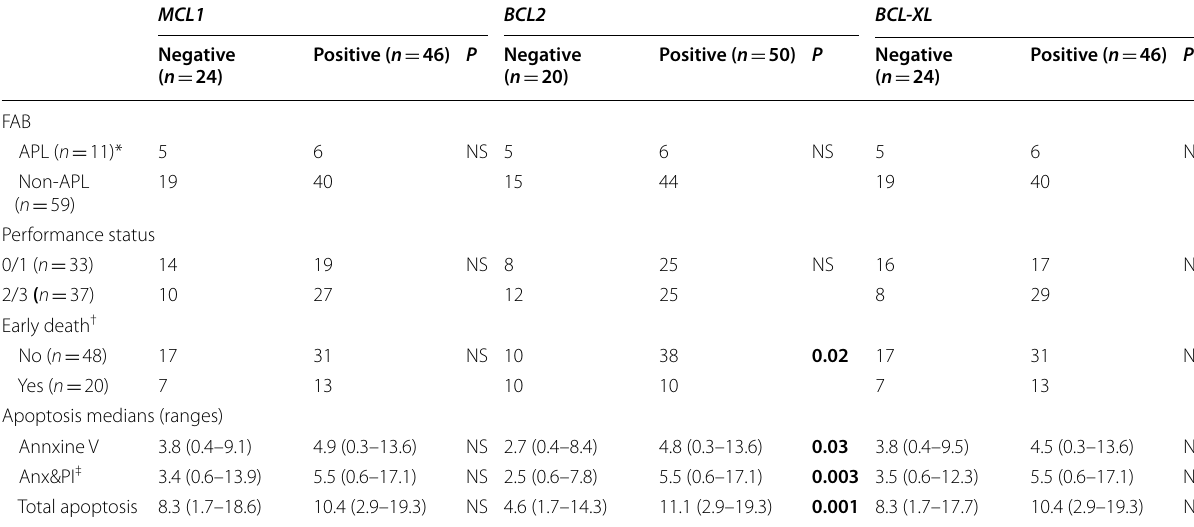
Table 3 MCL1, BCL2, BCL-XL gene expression in AML cases ( n